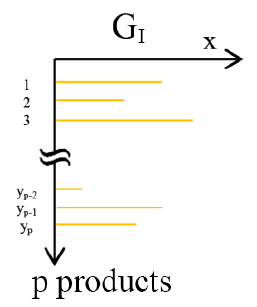
Figure 3. Formation of product families.